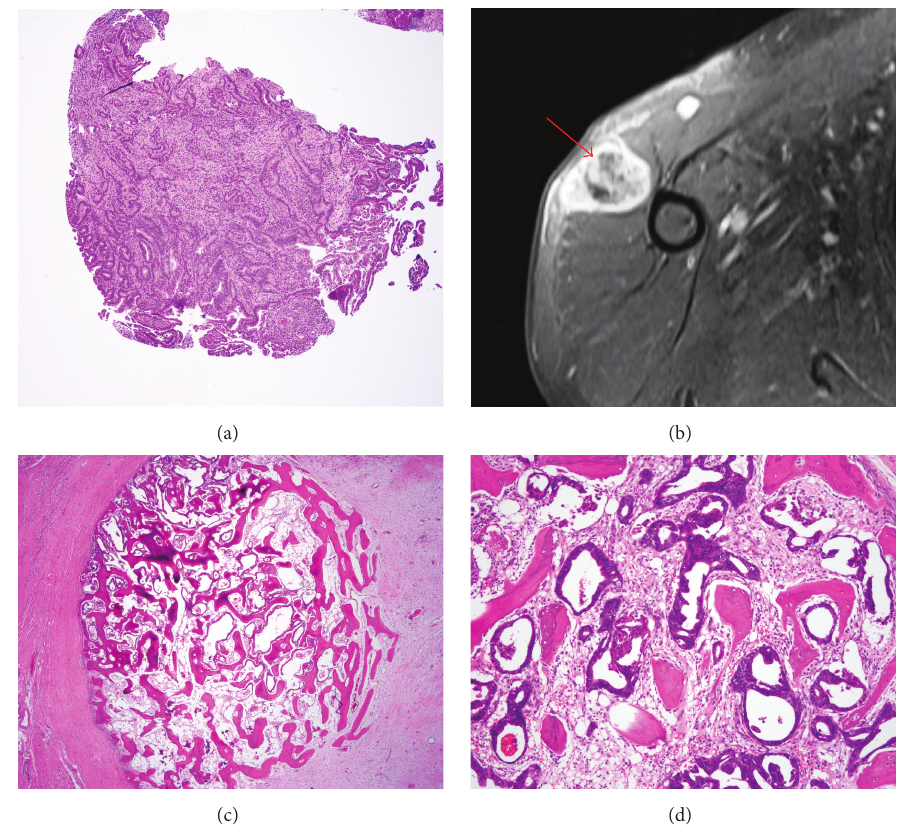
Figure 1: Case 1 histologic features of the esophageal mass and soft tissue mass. (a) Biopsy of the distal esophageal mass demonstrated infiltrating moderately differentiated neoplastic glands consistent with primary esophageal adenocarcinoma in a background of goblet cell (intestinal) metaplasia (H&E, 40x). (b) MRI of the deltoid muscle soft tissue mass highlighted bone and calcifications within the lesion that is distinctlyseparatefromthehumerus(redarrow).(c)Resectionofthesofttissuemassatlowpowermagnificationshowedawell-circumscribed mass of neoplastic glands closely associated with osteoblastic activity within skeletal muscle and fibrosis (H&E, 20x). (d) Resection of soft tissuemassathighermagnificationhighlightedmoderatelydifferentiatedneoplasticglandswithosteoblasticactivity,butlackingbonemarrow elements (H&E,